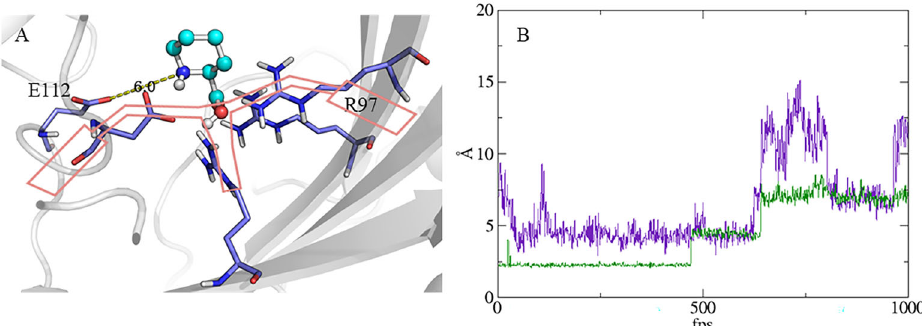
Figure 5. Prediction of potential sites for site-directed saturation mutagenesis. ( A ) Key residues related to substrate anchoring; E112 is 6 Å away from the amino group of L-Pip. ( B ) The dynamic changes of the distance between Y33 in the left flexible region and G282 (purple curve). The dynamic changes of the distance between Fe 2+ and the amino acid residue H107 that constituted the iron binding motif (green curve).